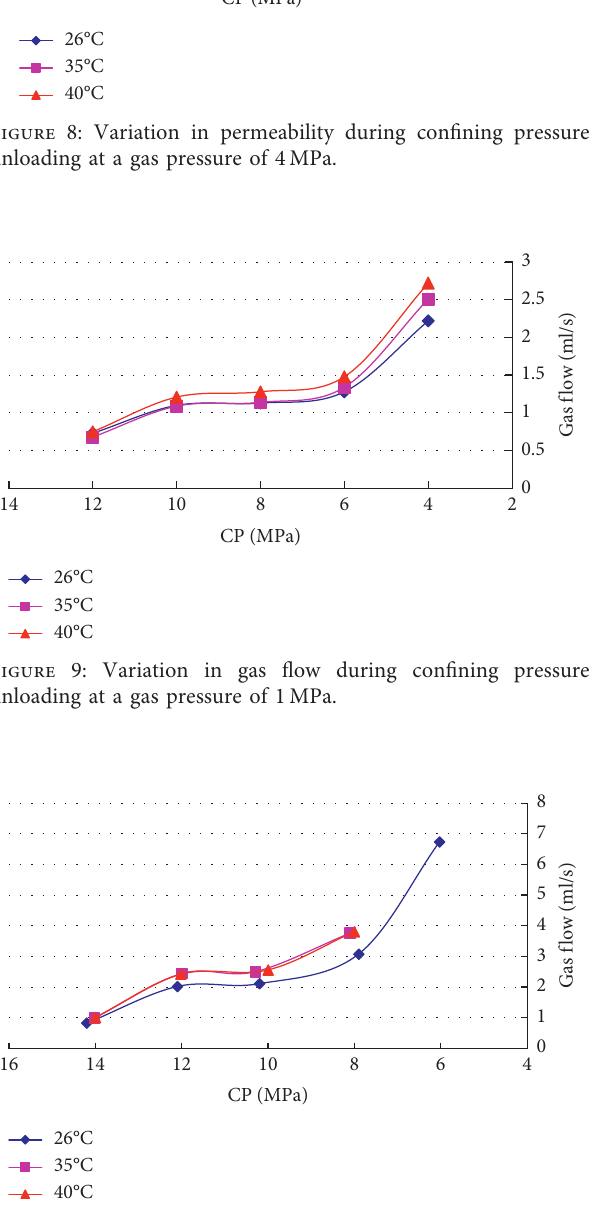
Figure 10: Variation in gas flow during confining pressure unloading at a gas pressure of 4